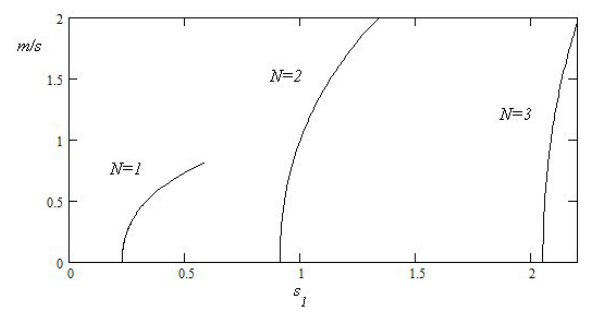
that the Rossby wave train propagates against the mean current